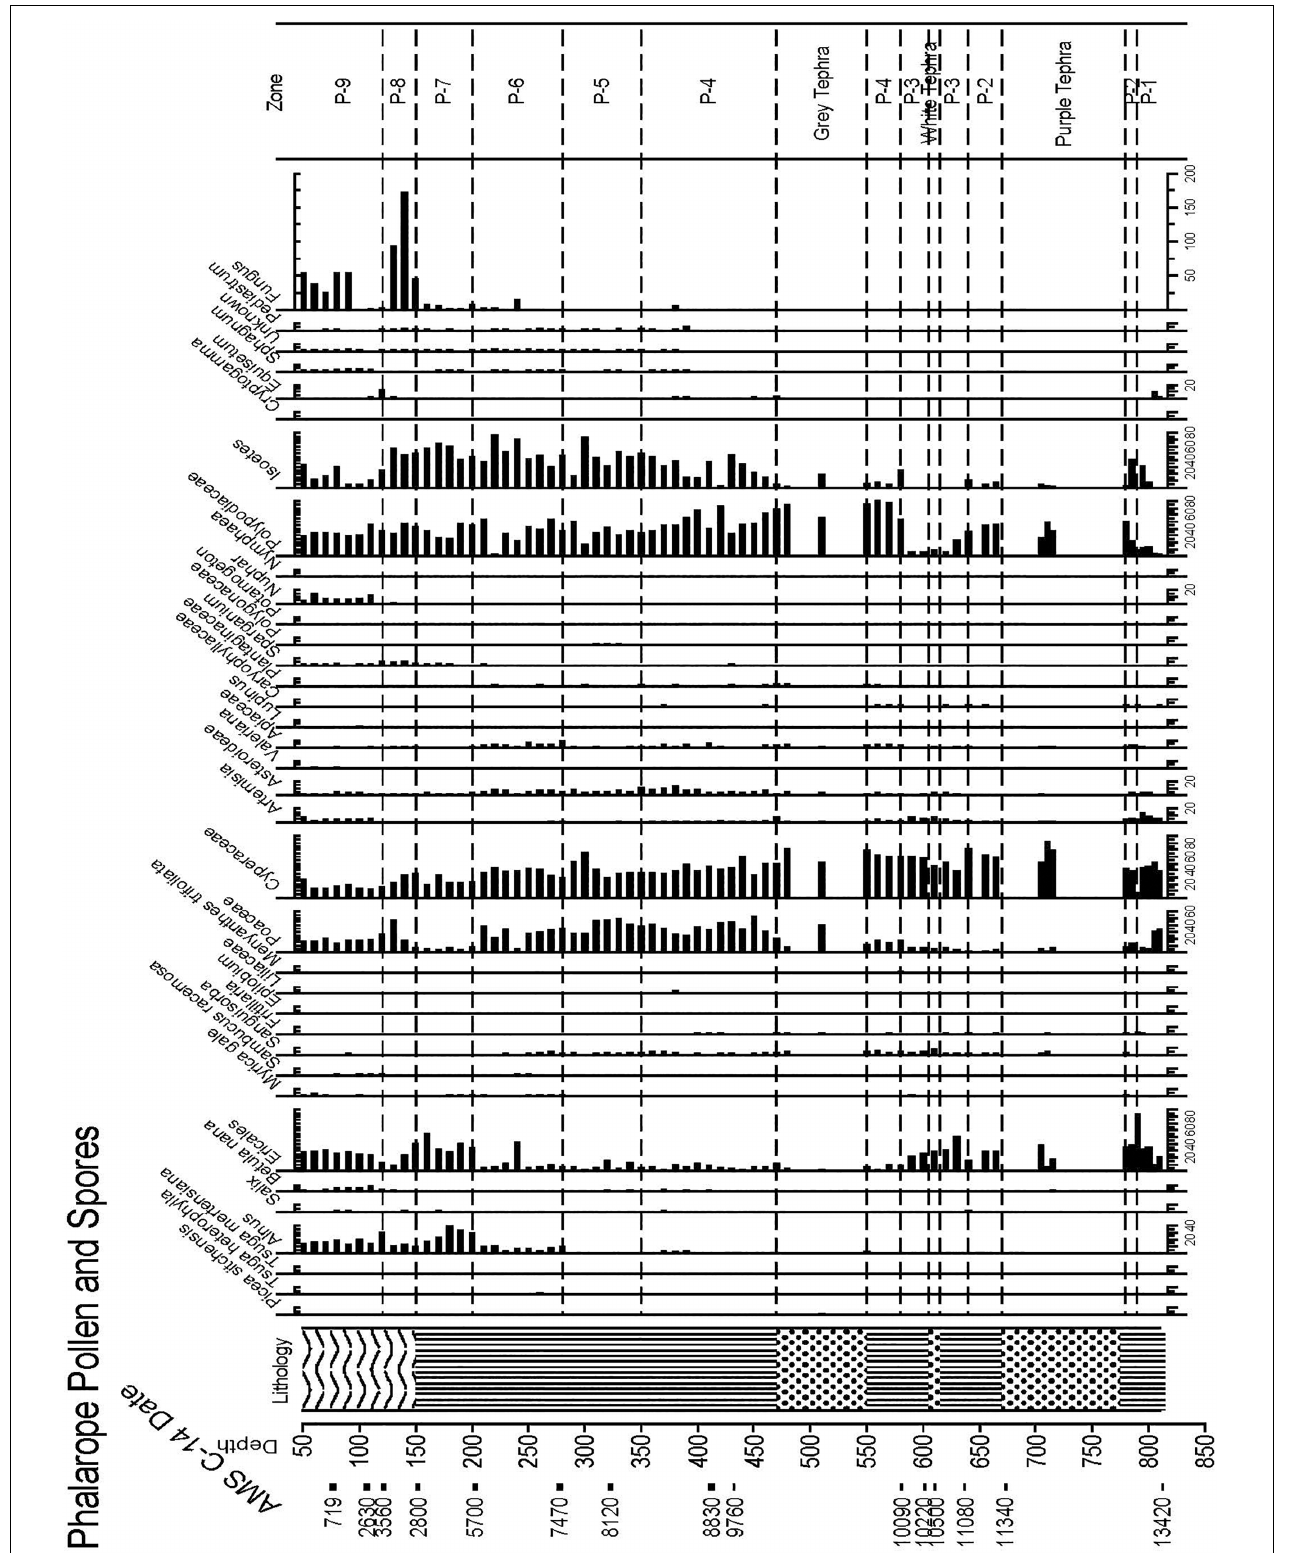
FIGURE 6 | Pollen and spore percentage data from Phalarope Pond, Kodiak Island.